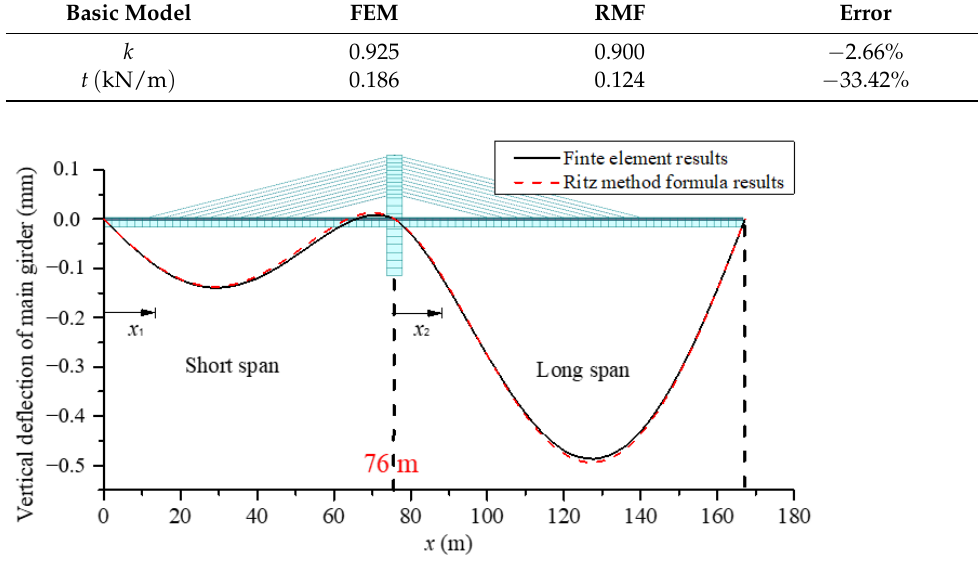
Figure 9. Comparison of girder deflections.